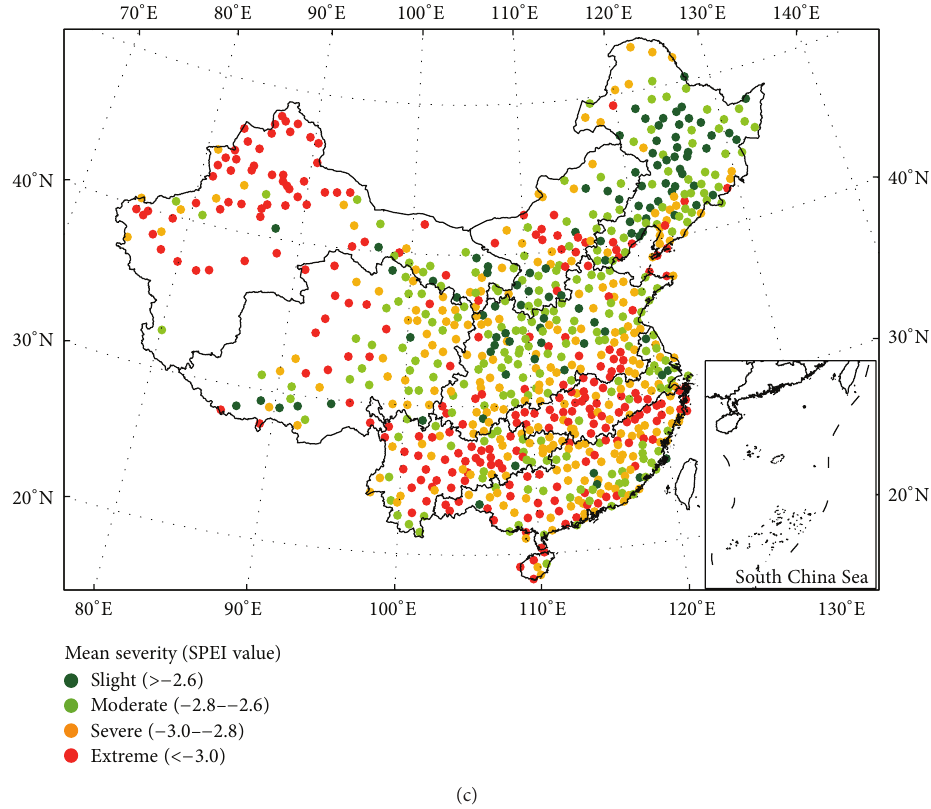
Figure 4: Spatial distribution of drought characteristics over China: (a) drought count; (b) mean duration; (c) mean severity.